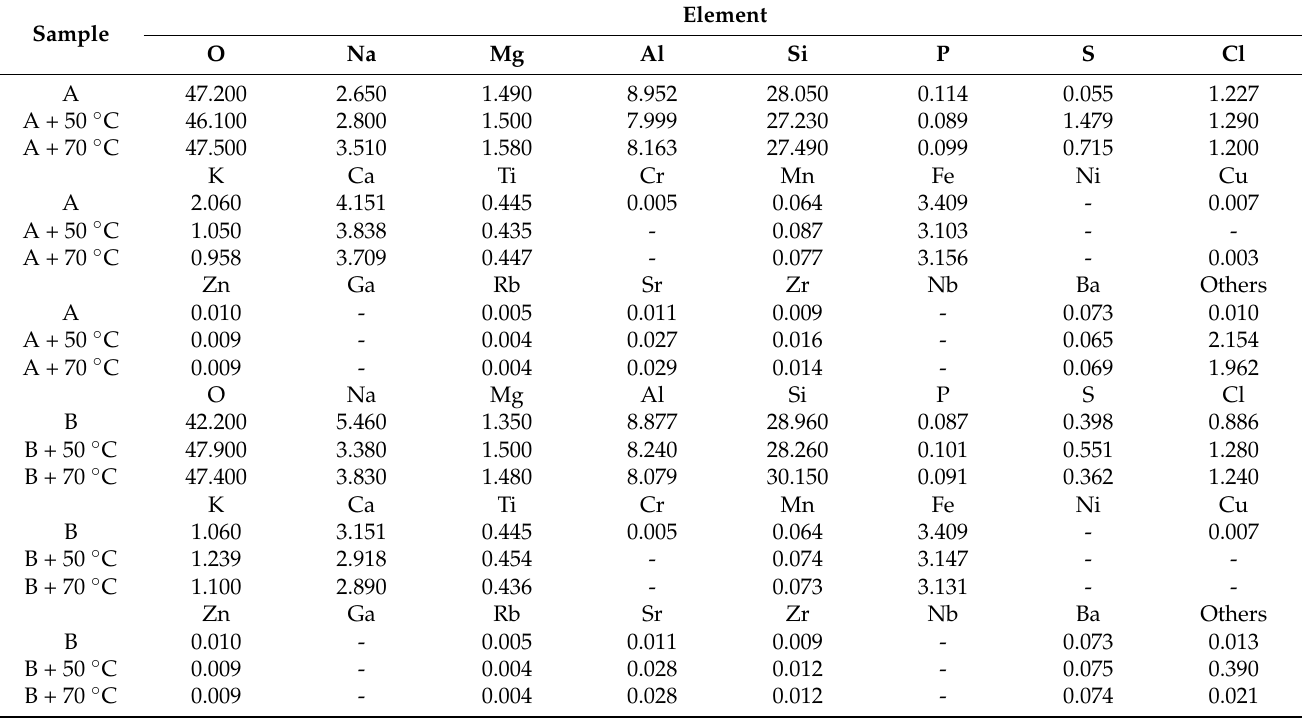
Table 4. X-ray fluorescence element content of Bentonite in Baojinshan